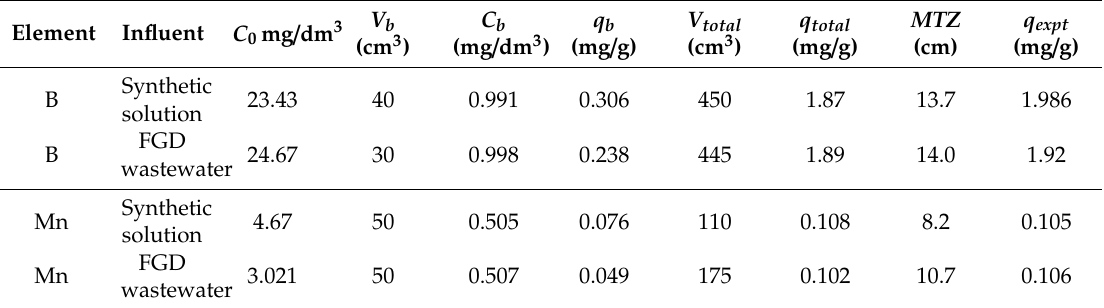
Table 3. Evaluation of the column mode performance of the hybrid chitosan-zirconium hydrogel beads for boron and manganese ions’